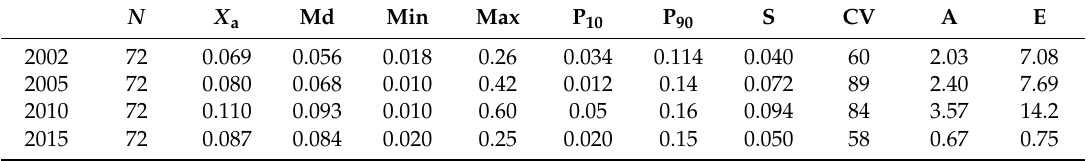
Table 1. Descriptive statistics of measurement according to sampling campaign, (in mg / kg). N X a Md